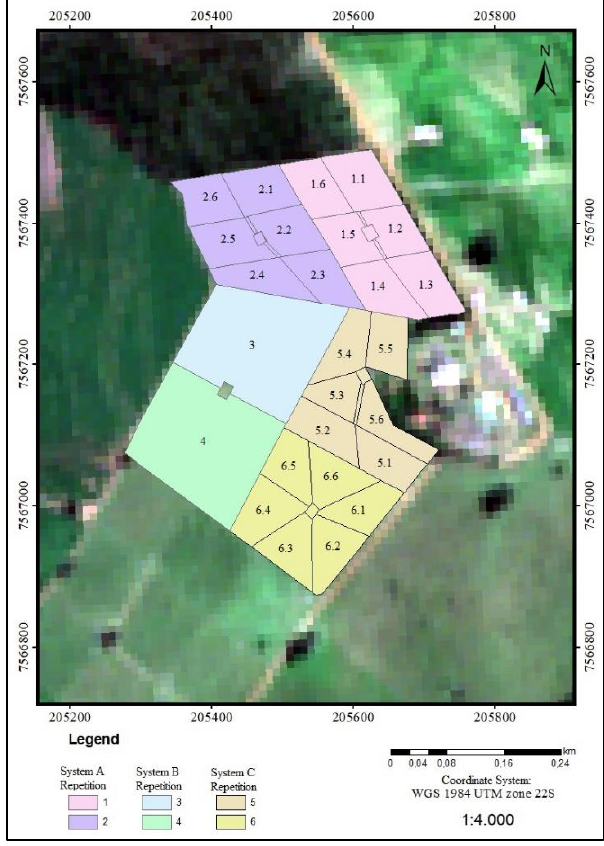
Figure 2. Distribution of the Piatã and Decumbens grassland, divided into three systems (A, B, C). The management of system A is crop-livestock integration (iCL), system B is an extensive system with continuous grazing method, and system C is intensive under rotated grazing method. Each one has two area repetitions: system A (paddocks 1 and 2), system B (paddocks 3 and 4), and system C (paddocks 5 and 6). Systems A and C are composed of six plots each. The numbers in the graph identify the plots. System B did not receive N, while systems A and C received, in total, 180 kg ha − 1 , which was applied four times with doses of 45 kg ha − 1 for each time.